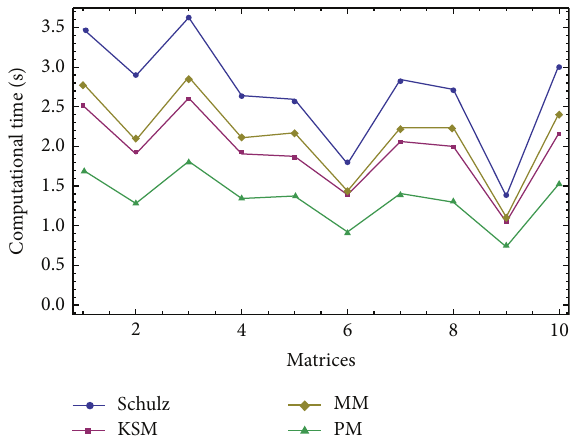
Figure 3: Comparison of the computational times for the 10 test sparse matrices in Experiment